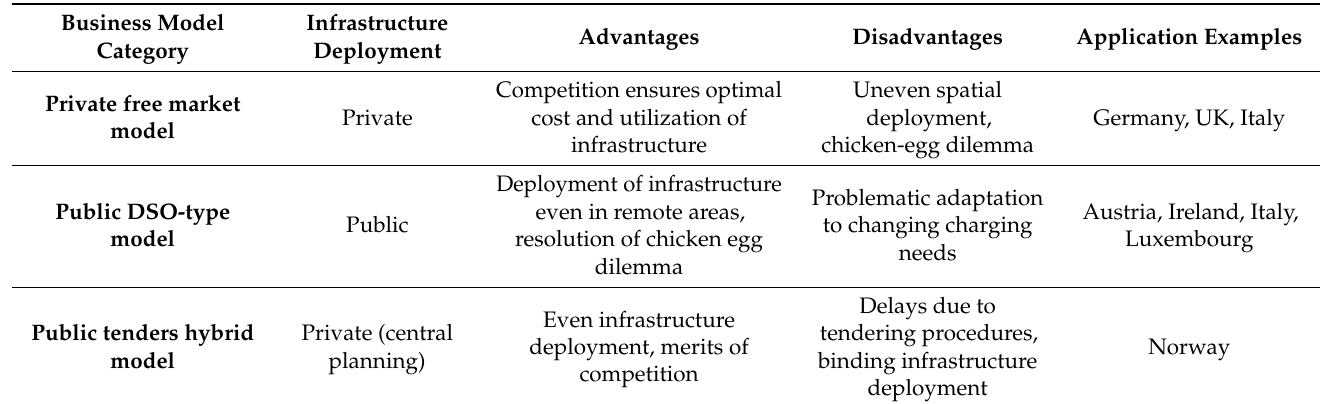
Table 1. Characteristics of private, public, and hybrid business models for